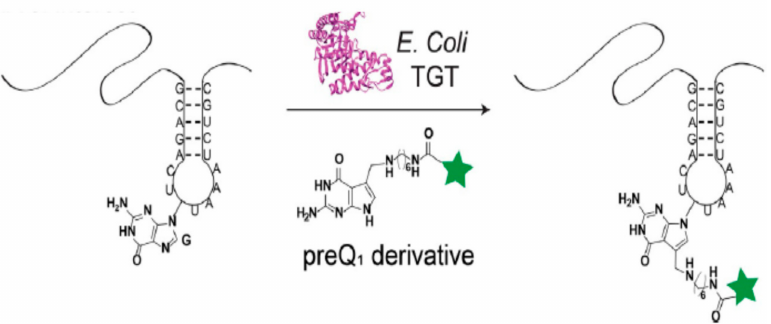
Figure 4. Site- specific TGT labeling of RNA. Reprinted with permission from reference